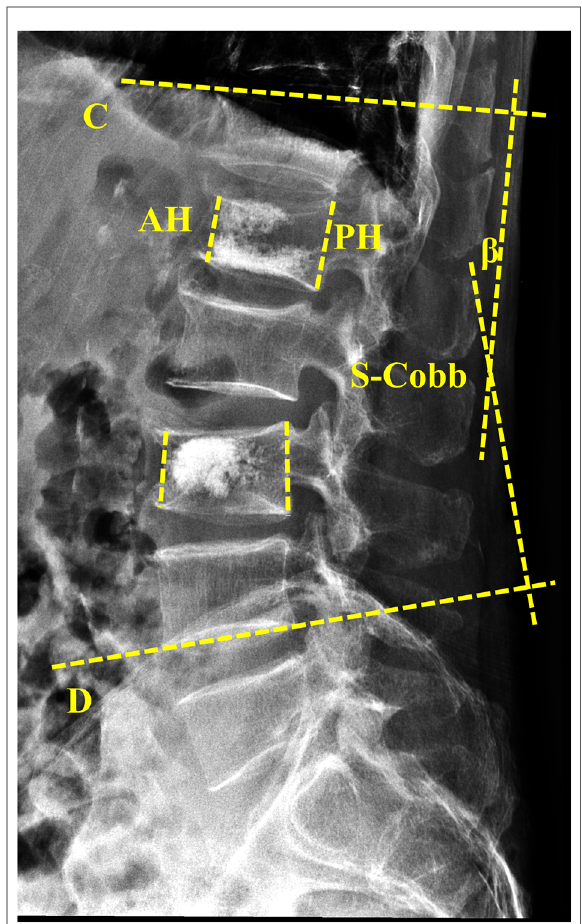
FIGURE 2 Measurements of sagittal segmental cobb (S-cobb) and the vertebral compression ratio (VCR). The heights of both anterior (AH) and posterior (PH) vertebral body were measured through lateral thoracolumbar radiography. The vertebral compression ratio (VCR) was calculated as the following formula: VCR=|PH – AH|/PH. The Sagittal Segmental Cobb (S-Cobb) angle β was measured from lateral thoracolumbar radiograph by recording the angles between line C and line D, which were measured between the inferior, superior adjacent treated vertebras through lateral